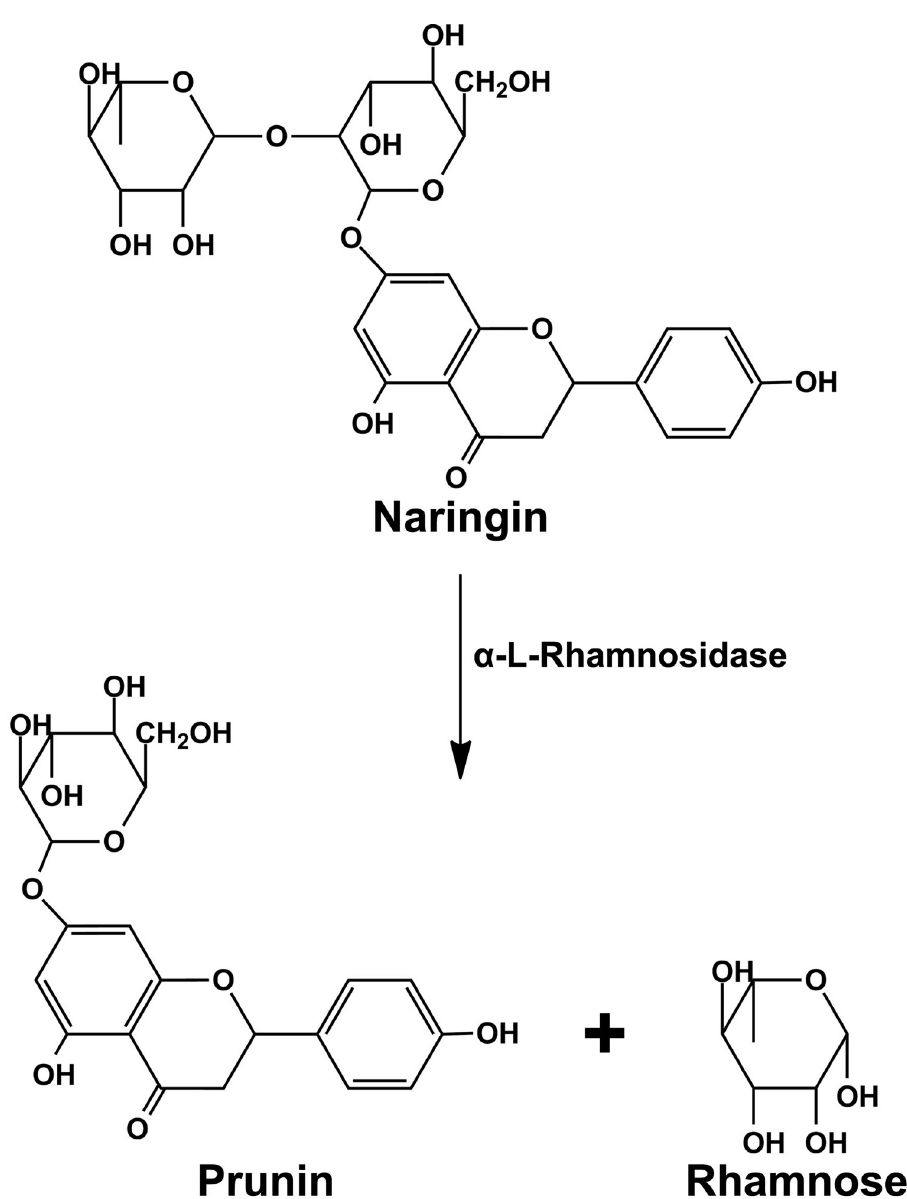
Fig 1. α -L-rhamnosidase catalyzes the hydrolysis of naringin to prunin and rhamnose. maintaining enzymatic activity, are identified based on their RMSF values by MD at high tem- perature to accelerate unfolding, and they are used as designed regions. The residues in the designed regions were allowed to be any of standard amino acids to increase their rigidity and favorable interactions with their neighboring residues. The best designed mutants were sub- jected to MD validation at high temperature and optimum temperature of the wild type to vali- date whether their designed regions have lower flexibility than the wild type, based on their RMSF values. The designed mutants with decreased flexibilities of the highly flexible regions are promising enzymes with high potential for stability improvement, and they were further analyzed in terms of secondary structure and hydrogen bond interactions.